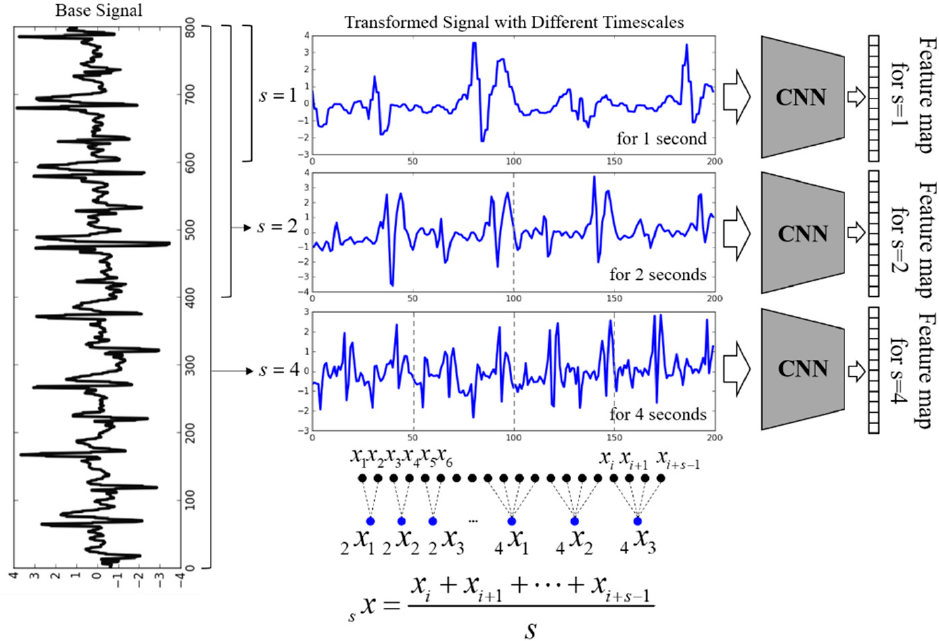
Figure 3. The proposed multiscale and multiple CNN scheme to extract features. Even if the scaling factor is different, the size of converted signals is same. The multi-scaled signals are fed into each CNN, and then each feature map is generated.